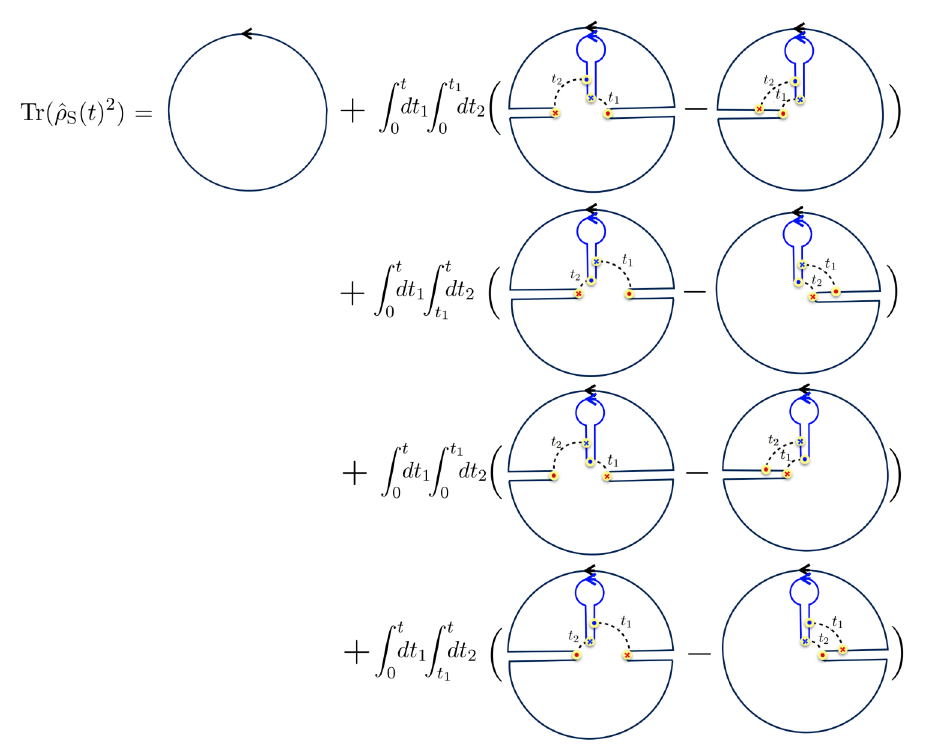
( t )) , up to g 2 order. Diagram representation of eq. S